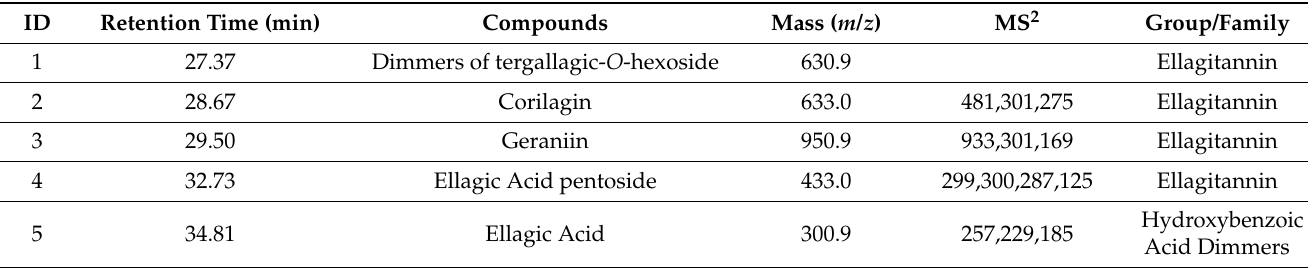
Table 1. Identification of obtained compounds from Mexican rambutan (cid:48) s peel polyphenolic